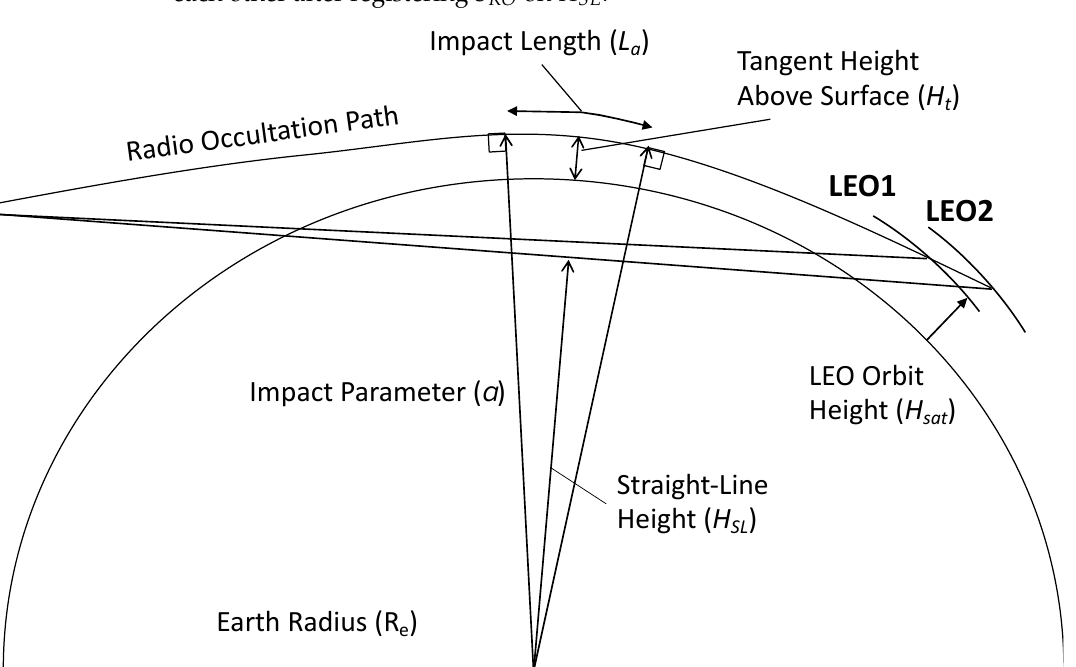
( b ) Figure 5. The mean S RO profiles from COSMIC-1 and GRACE from July 2008 when their orbital altitudes were respectively at 810 and 350 km: ( a ) as a function of H SL , ( b ) as a function of 𝐻(cid:3553) (cid:3020)(cid:3013) .